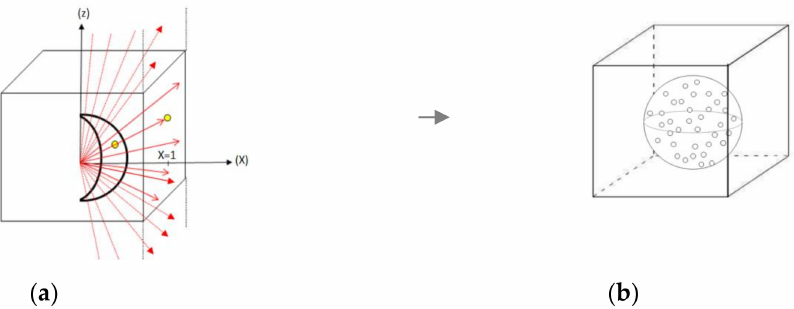
Figure 7. ( a , b ) Projection of the 1st region of the sphere on the 1st facet of the cube (plane x =